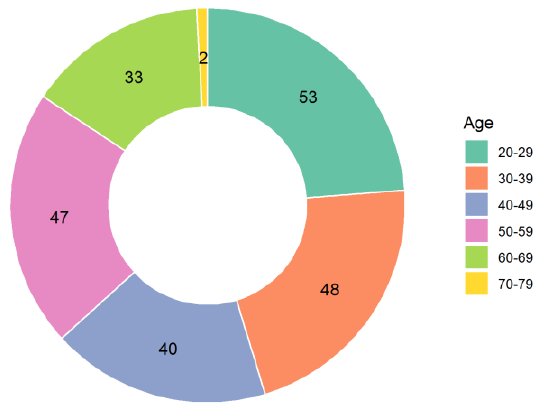
Figure 2. Age ranges of the respondents.